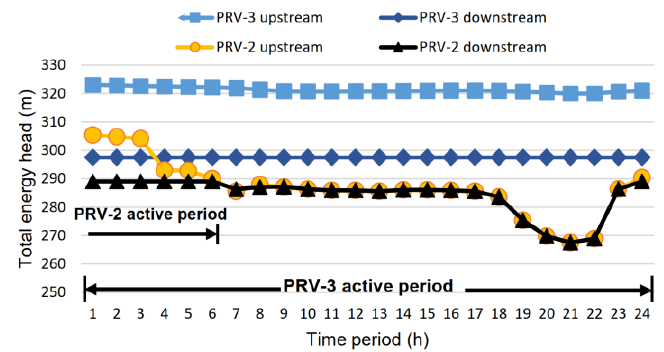
Figure 8. PRV-2 and PRV-3 upstream and downstream node head.